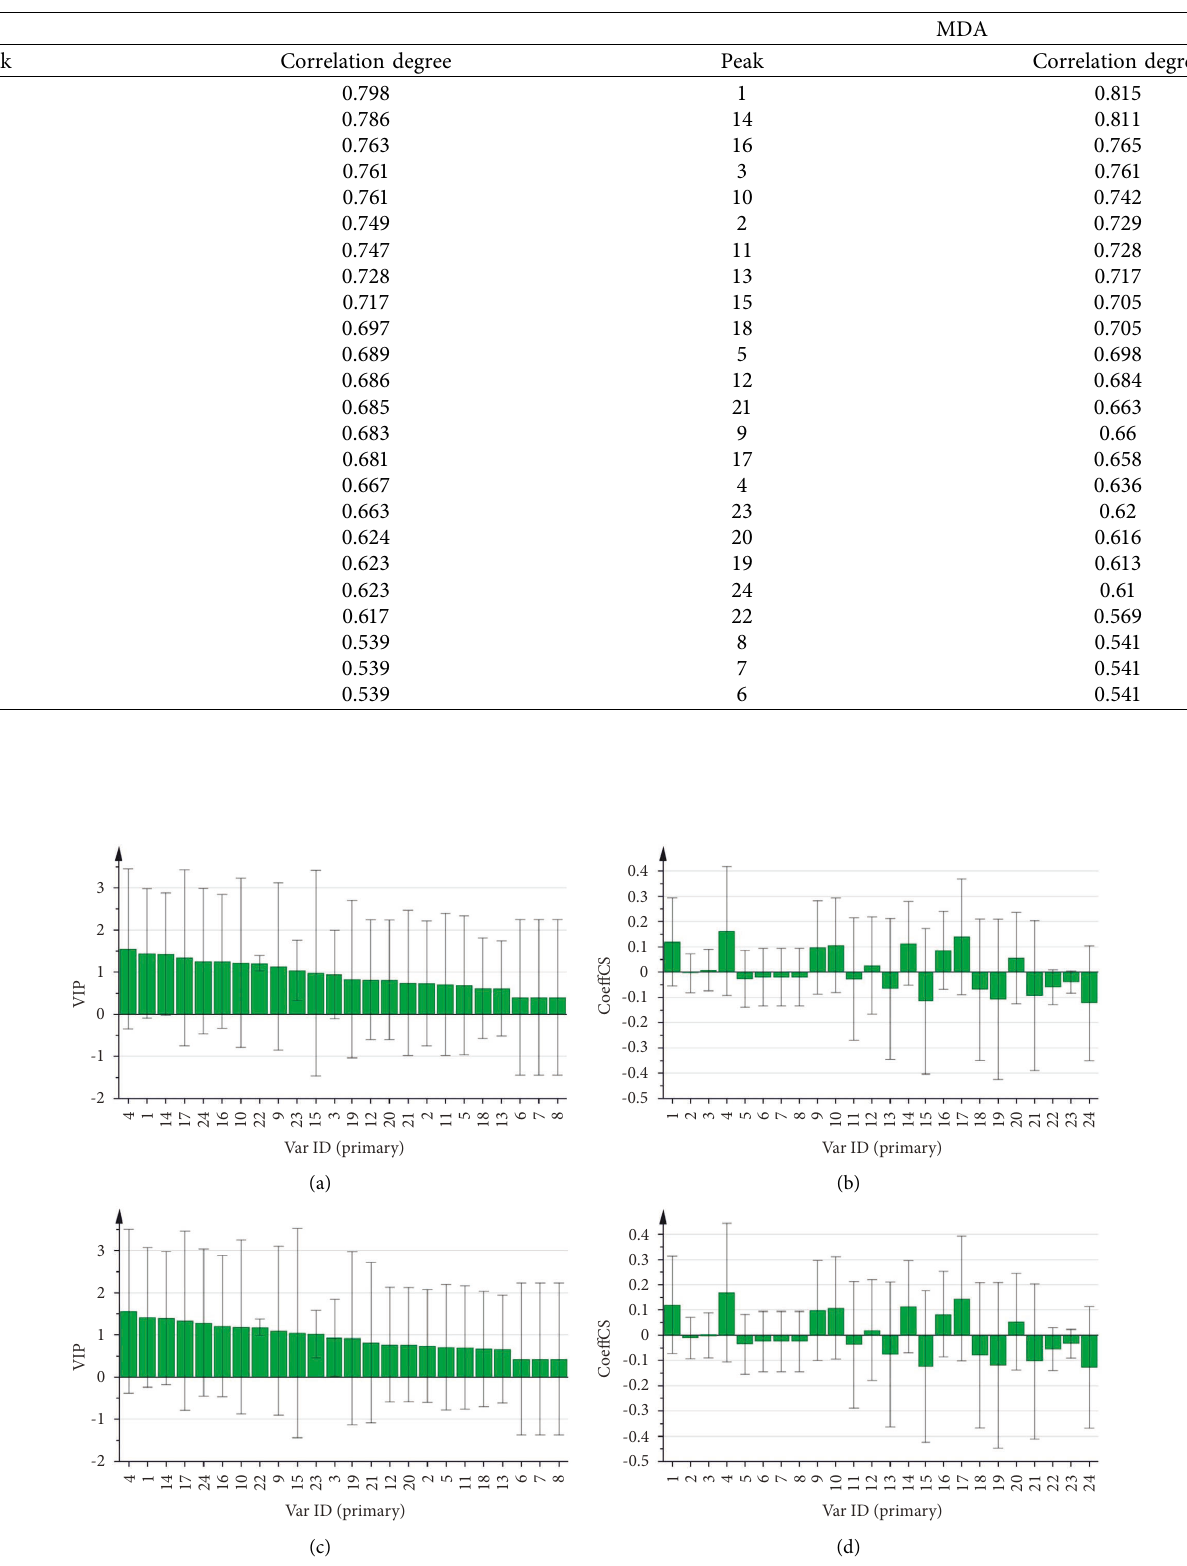
Table 1: Correlation degree of BHD extracts with their pharmacodynamics.